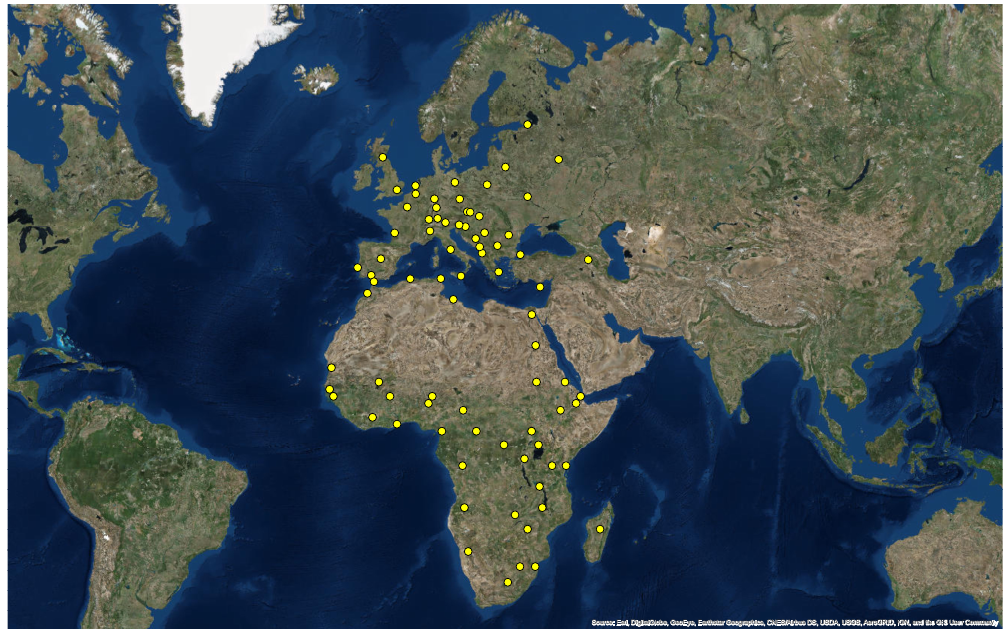
Figure 3. Randomly chosen geographical locations for the analysis (the full list of coordinates is reported in the Appendix A). The data set consists of 80 locations, 40 in Europe and 40 in Africa. Map source: ESRI World Imagery